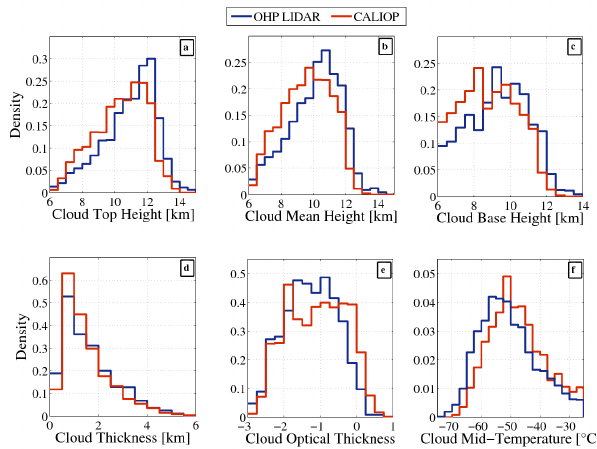
Figure 4. Probability density functions of macrophysical cirrus clouds parameters derived 2 Fig. 4. Probability density functions of macrophysical cirrus clouds from the OHP lidar (blue) and CALIOP (red). Panels a to f correspond respectively to the 3 parameters derived from the OHP lidar (blue) and CALIOP (red). distribution of the cloud top, mean and base height, the cloud geometrical and optical 4 (a) to (f) correspond respectively to the distribution of the cloud top, thickness, and the mid-cloud temperature. 5 mean and base height, the cloud geometrical and optical thickness, and the mid-cloud temperature.